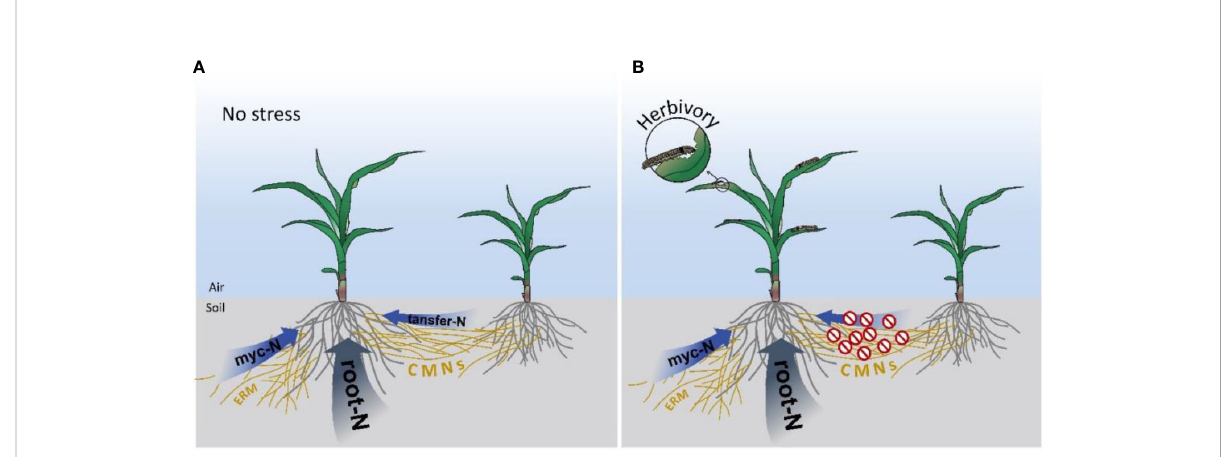
FIGURE 5 Diagram of pathways for N uptake in maize plants. (A) Pathway for maize plant N uptake under no stress. (B) Diagram of the pathway for maize plant N uptake under herbivory. Myc-N, N uptake by mycorrhizal pathway from soil; root-N, N uptake by root from soil; transfer-N, N obtained from the CMN-connected neighboring plant; , N transferred from a CMN-connected neighboring plant was